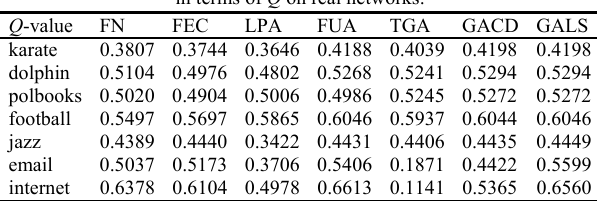
Table 2. Compare GALS with FN, FEC, LPA, FUA, TGA and GACD in terms of Q on real